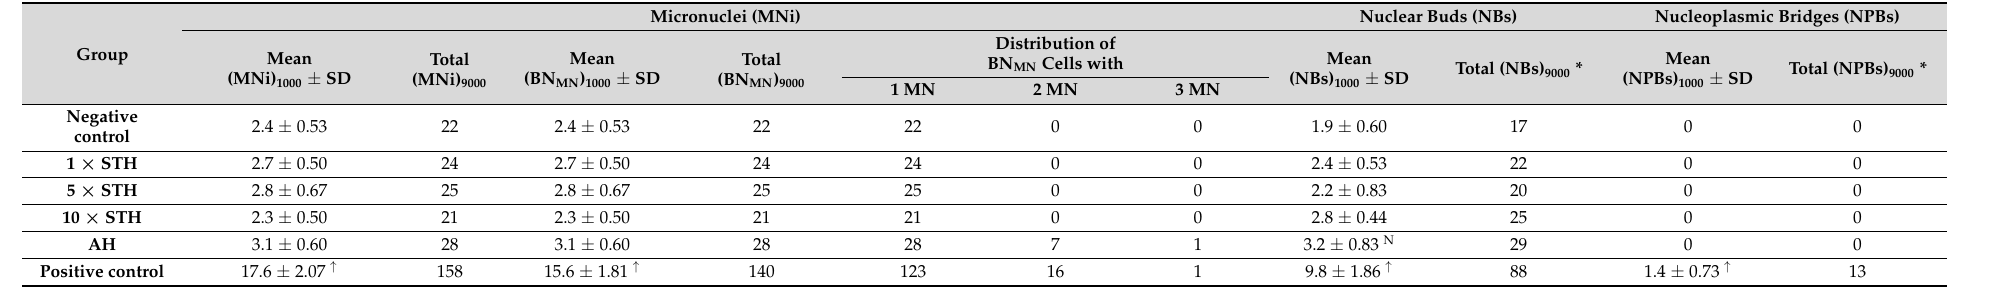
Table 2. Micronuclei (MNi), nuclear bud (NB), and nucleoplasmic bridge (NPB) formation in human lymphocytes after treatment with strawberry tree honey (STH) and artificial honey (AH). Negative control (non-treated cells) and positive control (bleomycin—15 mg/L) groups were studied in parallel.